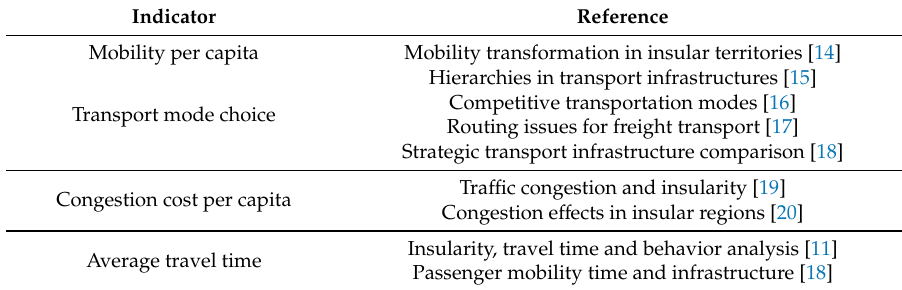
Table 1. Indicators of accessibility and logistical infrastructure of insular territories and related